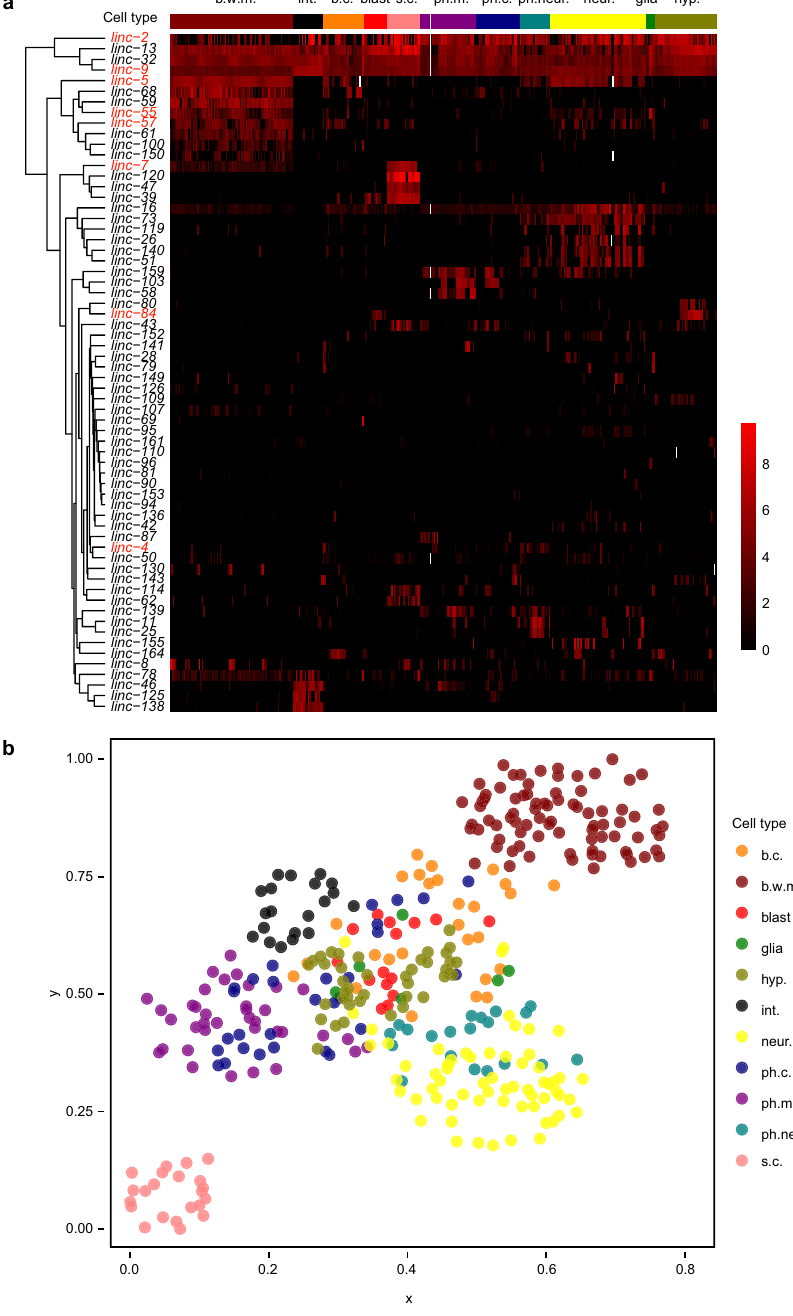
Figure 1. The single-cell expression profiles of lincRNA reporters. ( a ) lincRNA reporter expression profiles in newly hatched L1 larvae. The expression level of 64 PlincRNA::reporters in 361 somatic nuclei is shown. The gene expression level is adjusted by calculating (gene expression level + 500)/500, and is plotted as the log2 (adjusted gene expression level). Genes (rows) were clustered according to their expression pattern. 361 somatic cells (columns) were manually arranged according to their cell types and cell position along the anterior- posterior axis of the worm. Grey entries in the heatmap represent missing cells. The data used to generate this figure can be found in Supplementary Table S3. Gene names of eight lincRNAs that are significantly expressed in muscle according to previous SRT-based RNA-seq are in red 27 . ( b ) 361 somatic cells clustered by lincRNA promoter reporter expression. A terrain map of nuclei was generated by Genesis according to correlation of gene expression between cells 35 . Each dot represents a nucleus. Colors indicate different cell types. The distance between two nuclei in the x-y plane indicates similarity in gene expression. Cells with similar gene expression patterns are close to each other, while cells with different patterns are far apart. b.c., other body cells; b.w.m., body wall muscle; blast, blast cells; glia, glia cells; hyp., hypodermal cells; int., intestine cells; neur., neurons; ph.c., other pharyngeal cells; ph.m., pharyngeal muscle; ph.neur., pharyngeal neurons; s.c., seam